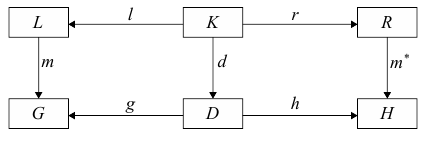
Figure 1. Double